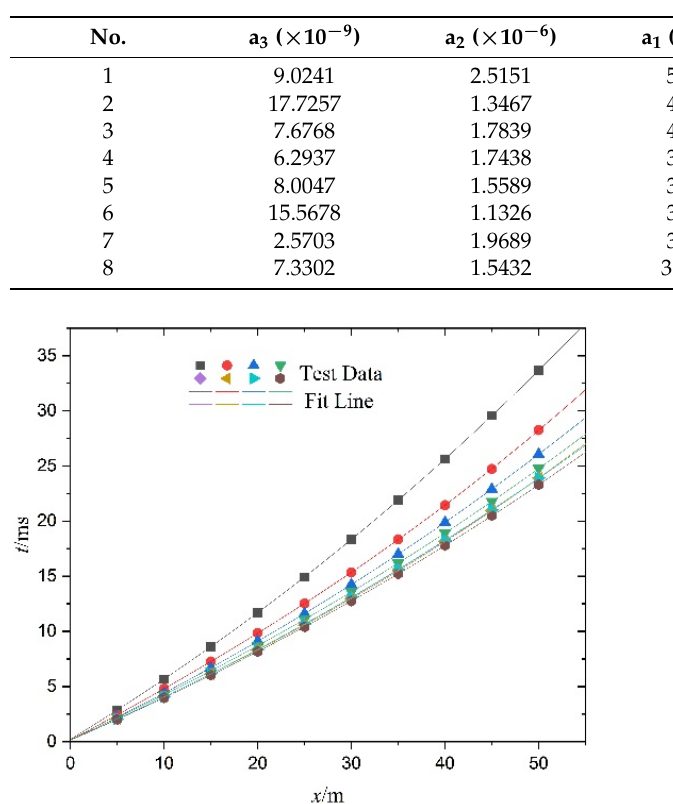
Table 4. Fitting parameters of fragment distance–time.